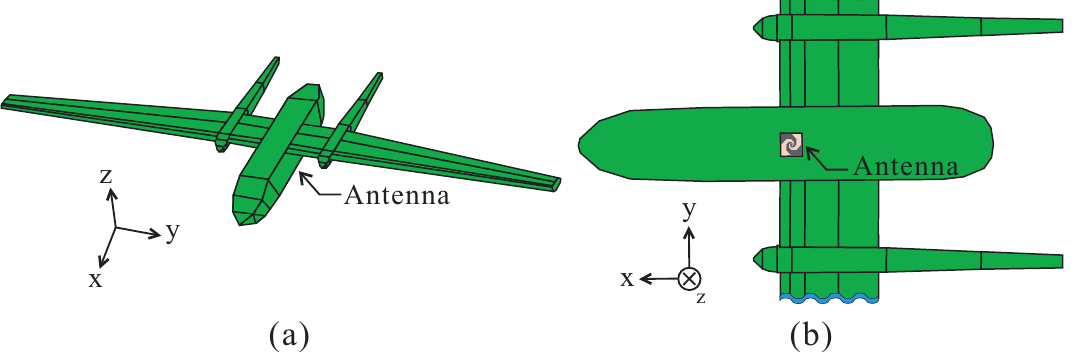
Figure 9. Proposed antenna mounted on a UAV model: ( a ) 3-D view; ( b ) Bottom